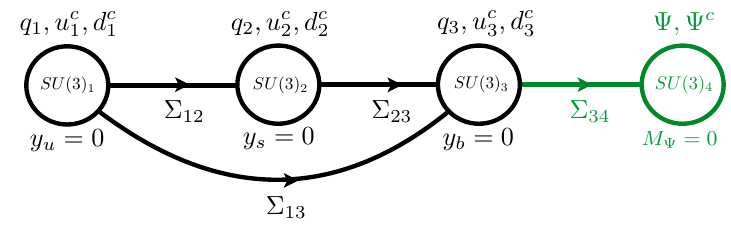
Figure 5 . The 3-site SU(3) 1 (cid:2) SU(3) 2 (cid:2) SU(3) 3 theory of (cid:12)gure 3 extended to contain an extra site with a more weakly coupled SU(3) 4 factor. There is no chiral matter at this site, and the (cid:18) 4 angle is removed by an anomalous U(1) PQ symmetry of a single vector-like quark species (cid:9) ; (cid:9) c . While